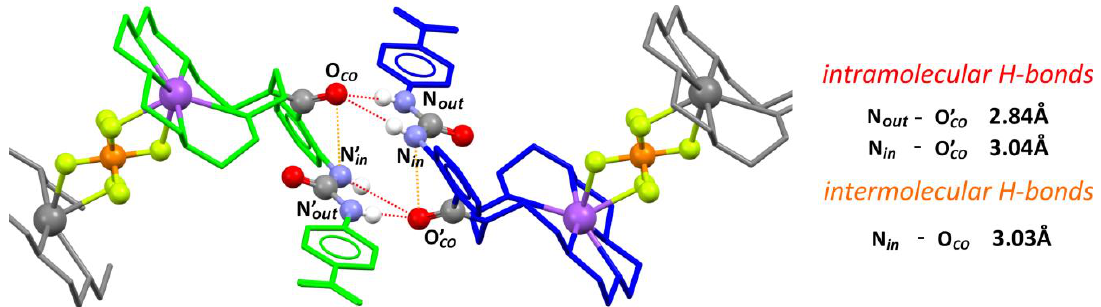
Figure 5. The crystal structure of dimer formed by complexes of 1 · NaPF 6 in the solid state: Green, blue, and gray color are used to distinguish between identical receptor molecules involved in the urea-carbonyl dimer formation and, further, a supramolecular polymer; urea and carbonyl groups are presented as balls in common colors; solvent molecules, most of hydrogen atoms, and disorder were omitted for clarity; selected hydrogen bonds are presented as red lines connecting corresponding donor and acceptor groups.